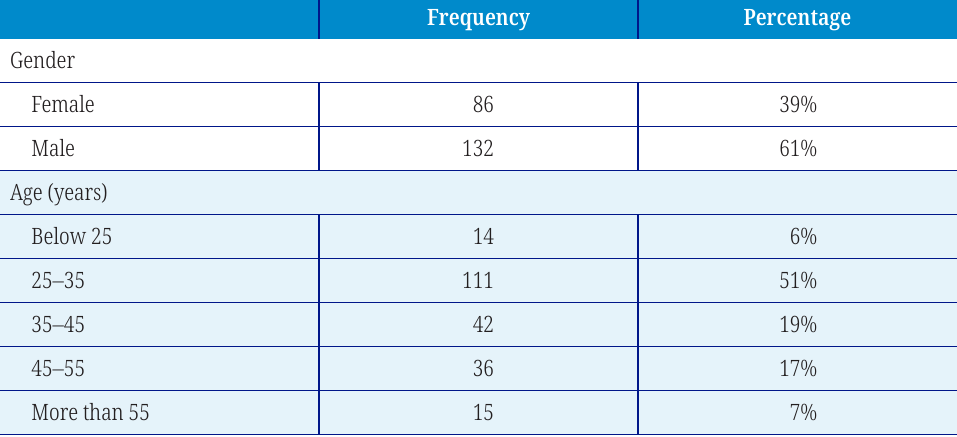
Table 2. Socio-demographic characteristics and professional data of study population (N =